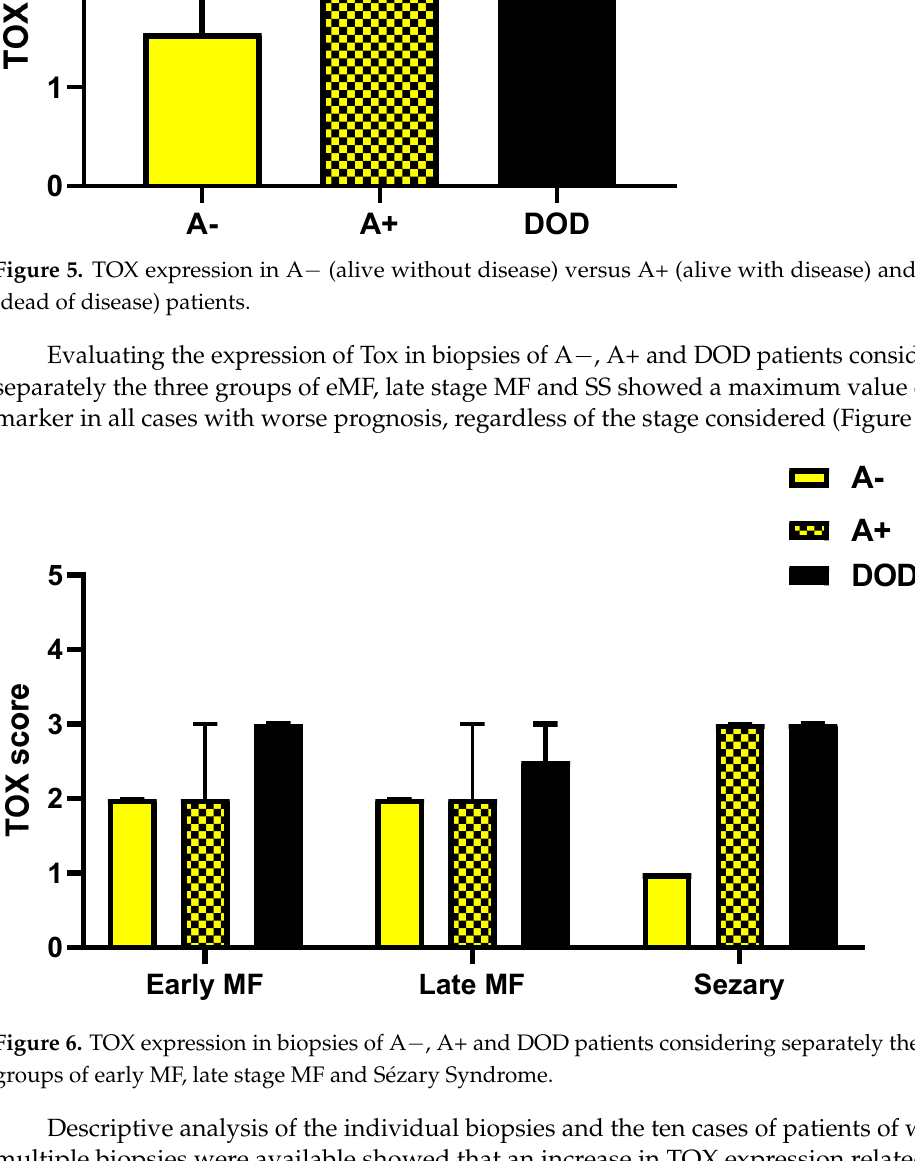
Figure 7. Tox expression in different biopsies of male patients performed during the clinical follow up of the disease.